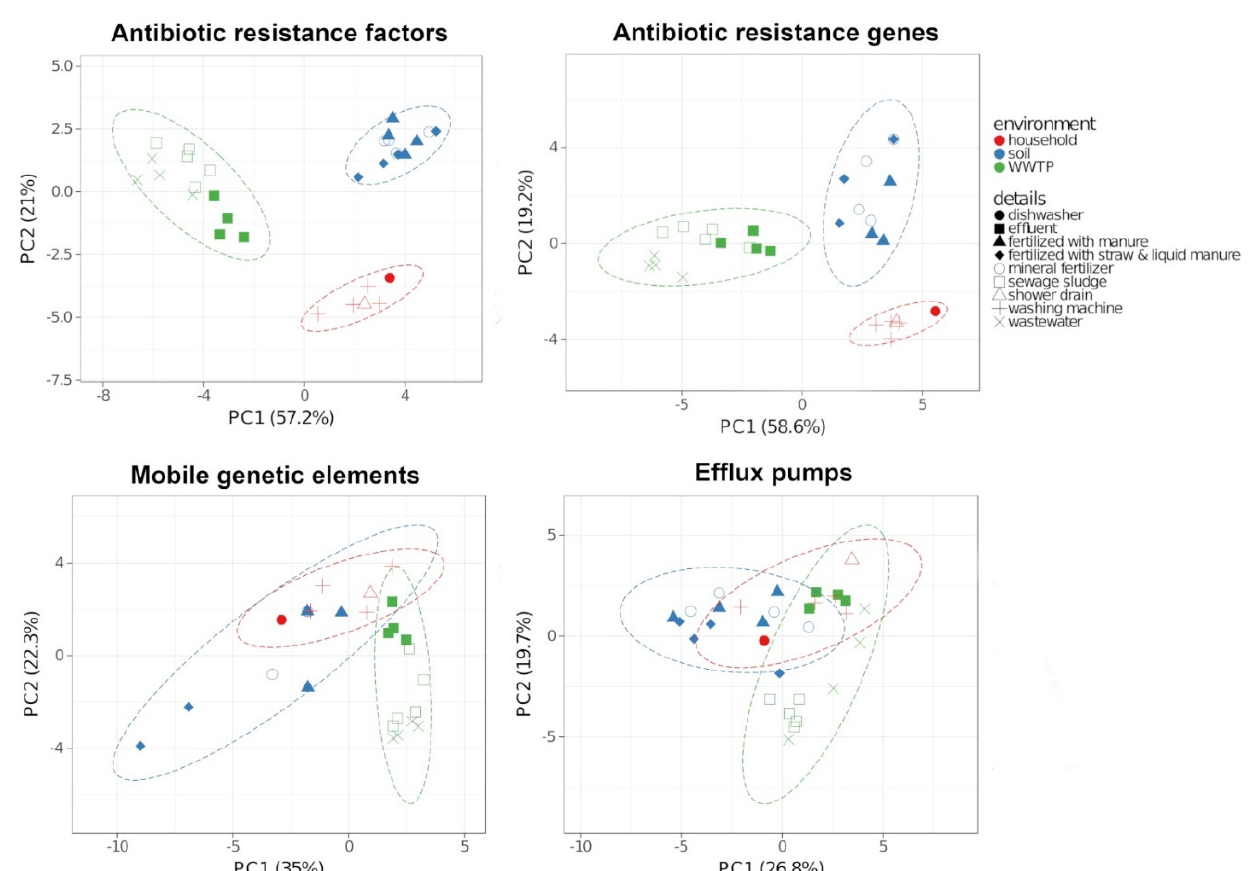
Figure 5. Principal component analysis (PCA) with 95% prediction ellipses based on Spearman correlation of the total of antibiotic resistance factors and its subgroups antibiotic resistance genes, mobile genetic elements and efflux pumps. Unit variance scaling was applied to rows and nonlinear iterative partial least squares (NIPALS) PCA was used to calculate principal components.